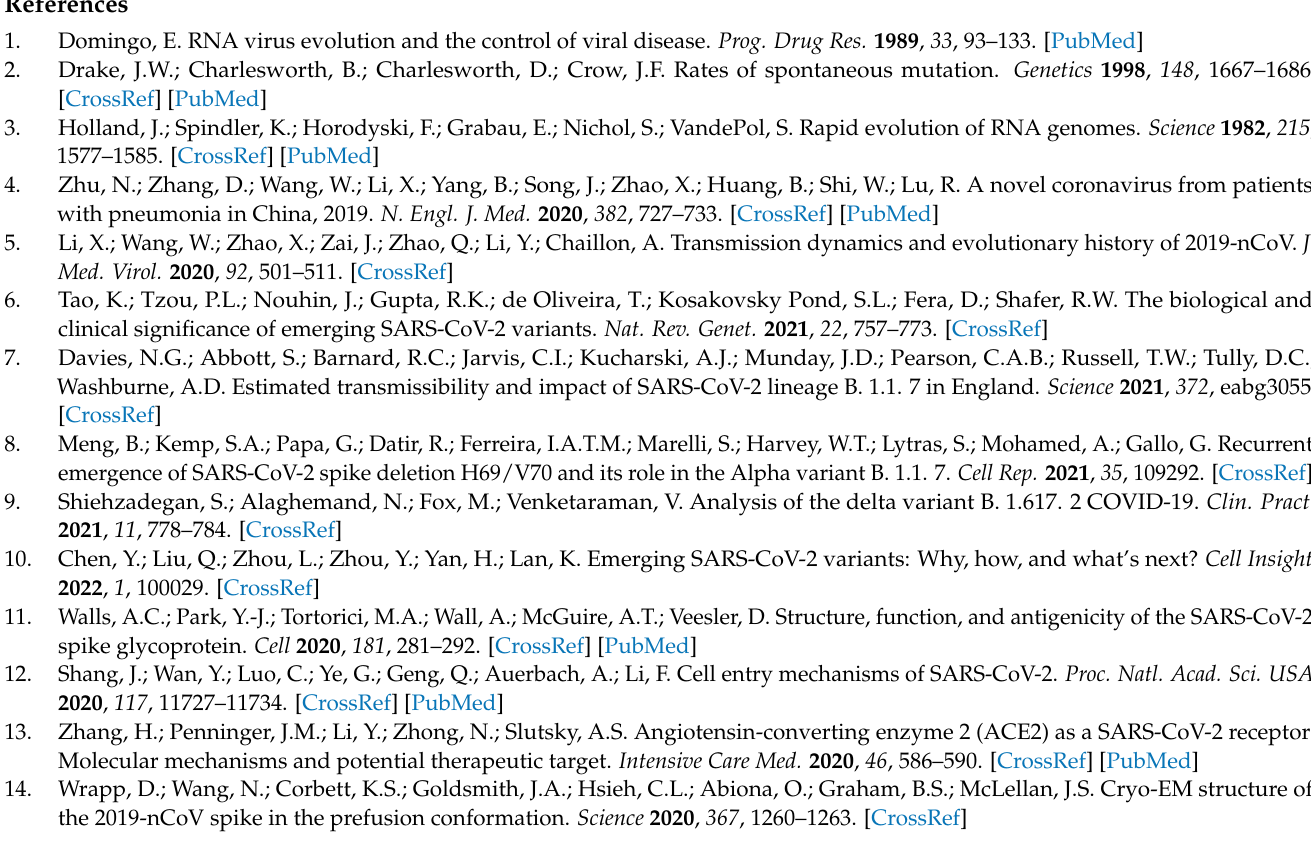
Figure S6: Complete flexibility profiles for RBD and ACE2; Table S1: Hydrophilic interaction values at the ACE2/RBD interface; Table S2: Hydrophobic interaction values at the ACE2/RBD interface; Table S3: Hydrophilic and hydrophobic interaction values at the ACE2/RBD interface detailed for each